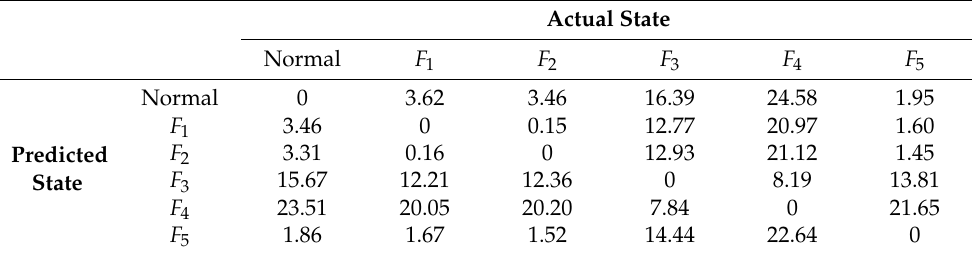
Table 4. The misdiagnosed cost matrix of the different states of the KPG